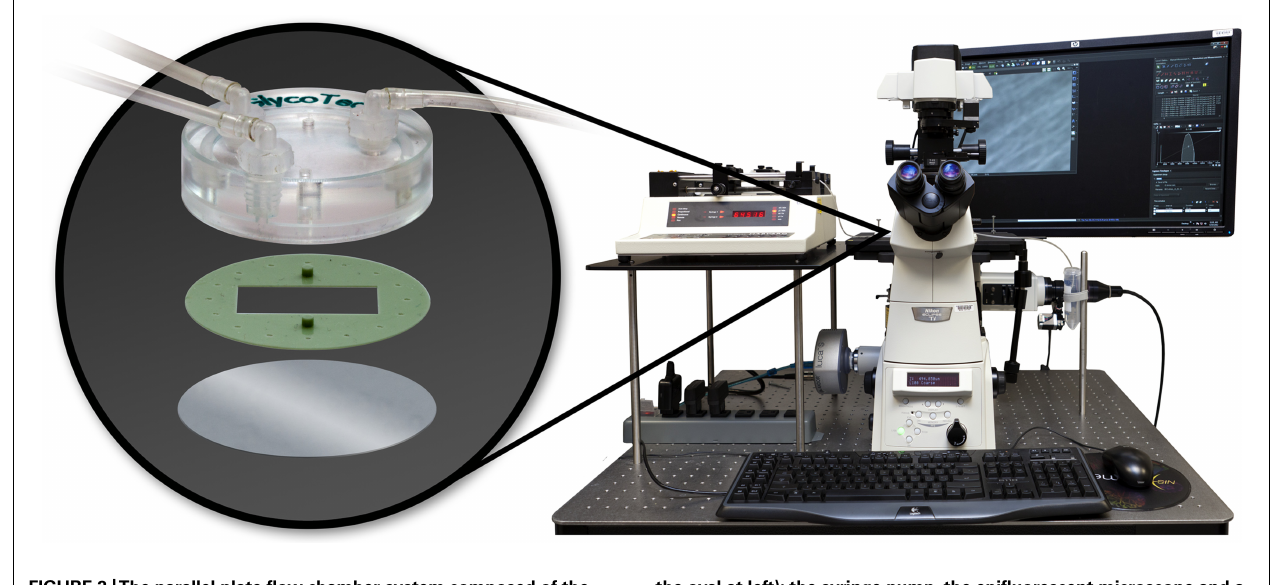
the oval at left); the syringe pump, the epifluorescent microscope and a desktop